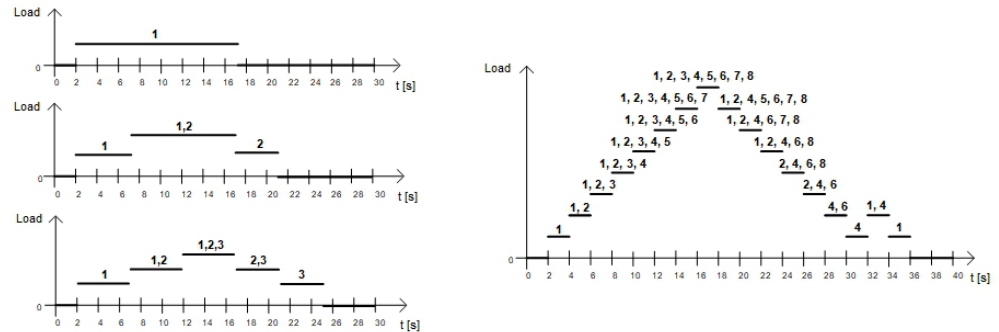
Figure 4. Data collecting jig: single, two, three, and eight loads ON and OFF